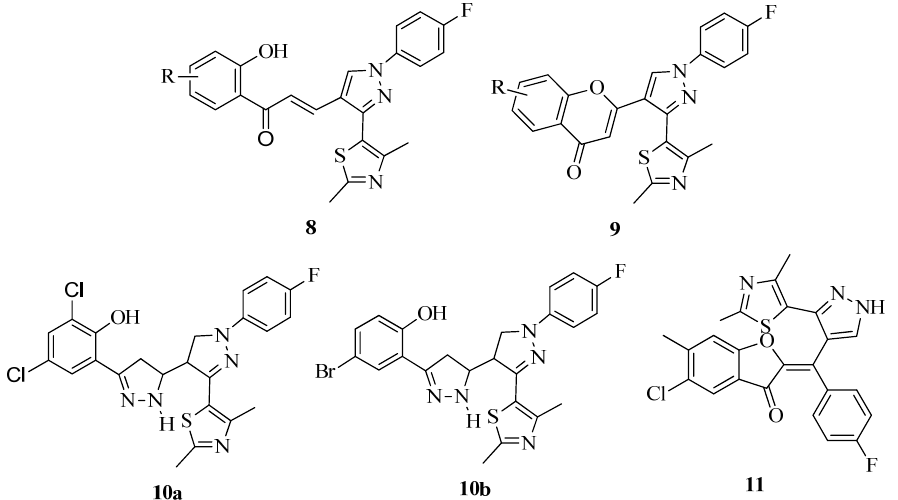
Figure 5. Structures of derivatives of 1-(2-hydroxyphenyl)-3-[3-(2,4-dimethyl-thiazol-5-yl)-1-(4-fluoro-phenyl)-1 H -pyrazol-4-yl]-propenone ( 8 ), 2-[3-(2,4-dimethyl-1,3-thiazol-5-yl)-1-(4-fluorophenyl)-1 H -pyrazol-4-yl]-4 H -chromen-( 9 ), 2-[3 ′ -(2,4-dimethyl-thiazol-5-yl)-1 ′ -(4- florophenyl)-3,4-dihydro-2 H ,1 ′ H -[3,4 ′ ]bipyrazolyl-5-yl]-phenol ( 10 ), 2-[3-(2,4-dimethylthiazol-5- yl)-1-(4-fluorophenyl)-1 H -pyrazol-4-ylmethylene]-benzofuran-3-one. Nagavelli et al. [49] synthesized a series of new 6-bromobenzo[d]thiazole-2(3H)-one derived 1,2,3-triazole derivatives ( 12a – j ) (Figure 6) with the aim to study their cytotoxici- ty and antibacterial activity as well. The synthesized compounds ( 12a – j ) were tested for their in vitro antibacterial activity against both Gram-positive and Gram-negative bacte- ria such as Streptococcus pyogenes (S. pyogenes), S. aureus, P. aeruginosa, and Klebsiella